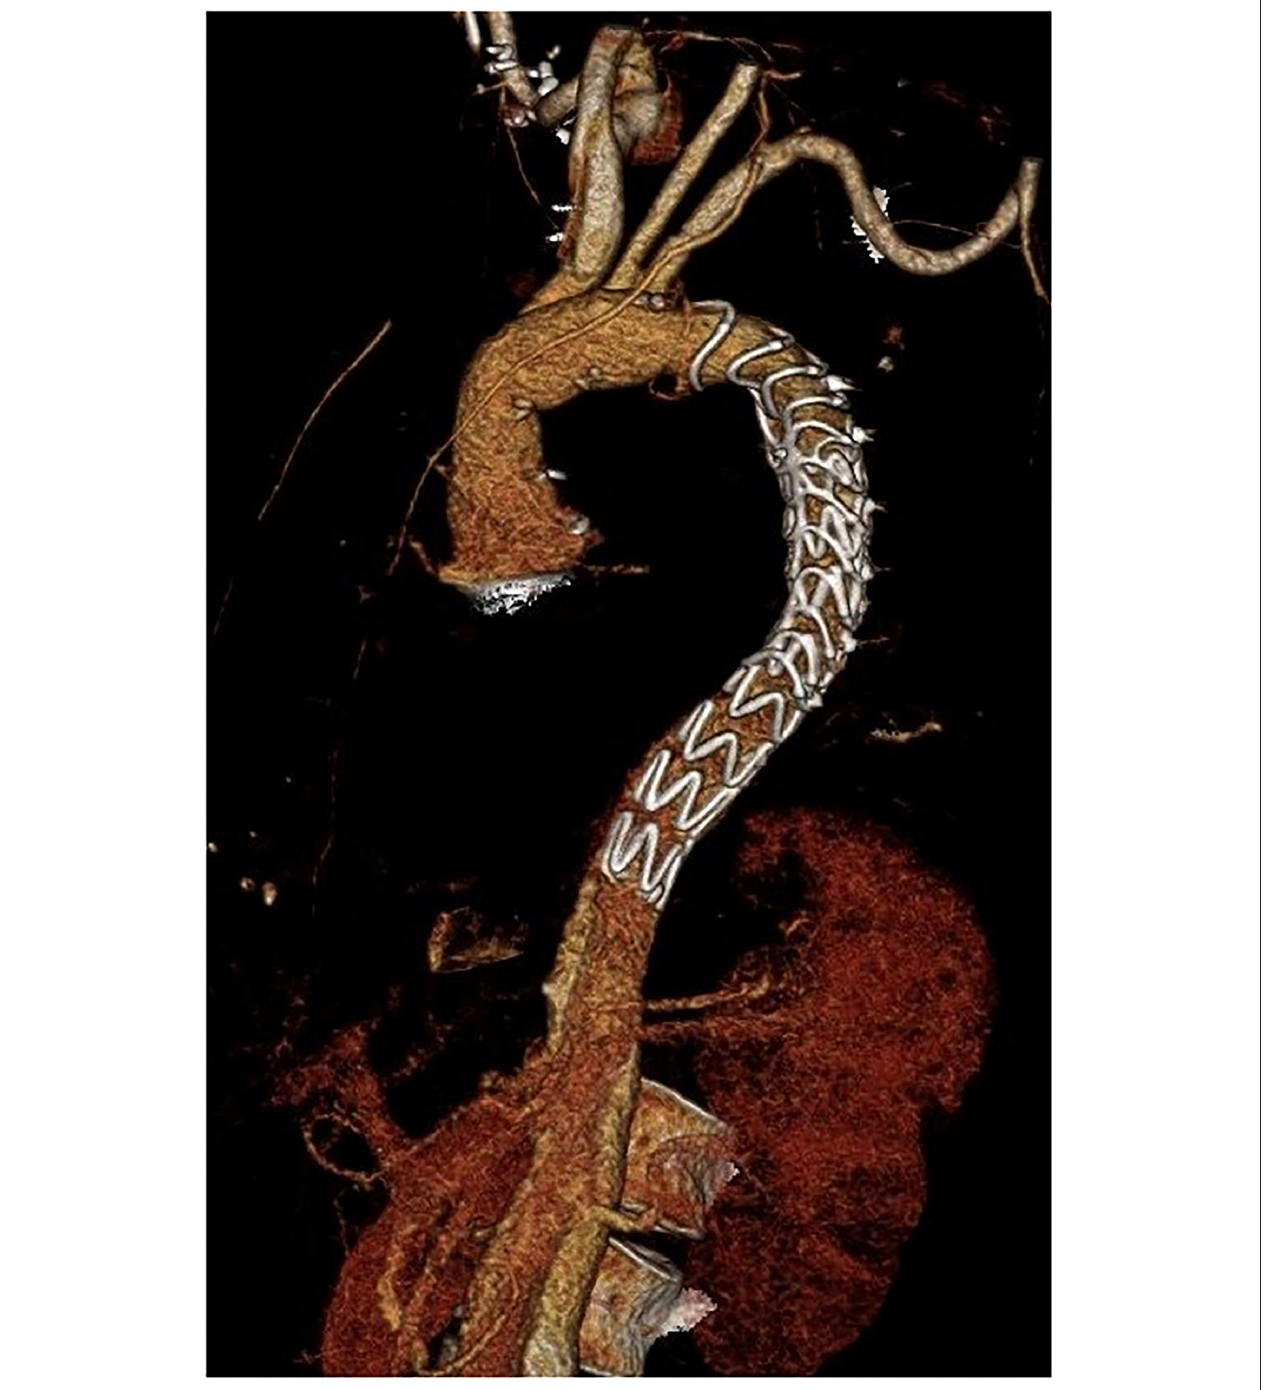
FIGURE 2 | Three-dimensional computer tomography angiography (CTA) after distal stentgraft extension succeeding after implantation of the Thoraflex Hybrid prosthesis.